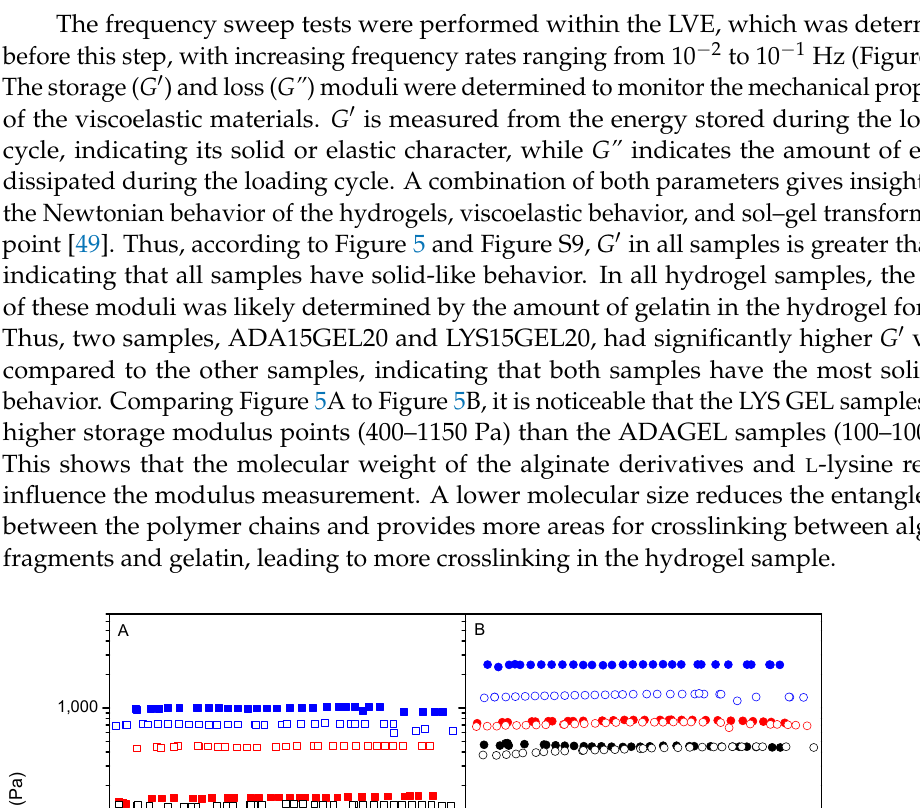
Figure 4. Apparent viscosity of ADA hydrogels ( A ), and ʟ -lysine functionalized ADA hydrogels ( B ) with different amount of ADA/f − ADA and gelatin.